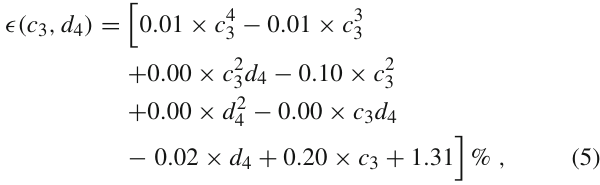
Fig. 4 The cross section for triple Higgs production with modified self-couplings ( λ 4 = λ SM ( 1 + d 4 ) and λ 3 = λ SM ( 1 + c 3 ) ) at the FCC- hh at 100 TeV, normalised to the SM value. The black star indicates the SM point